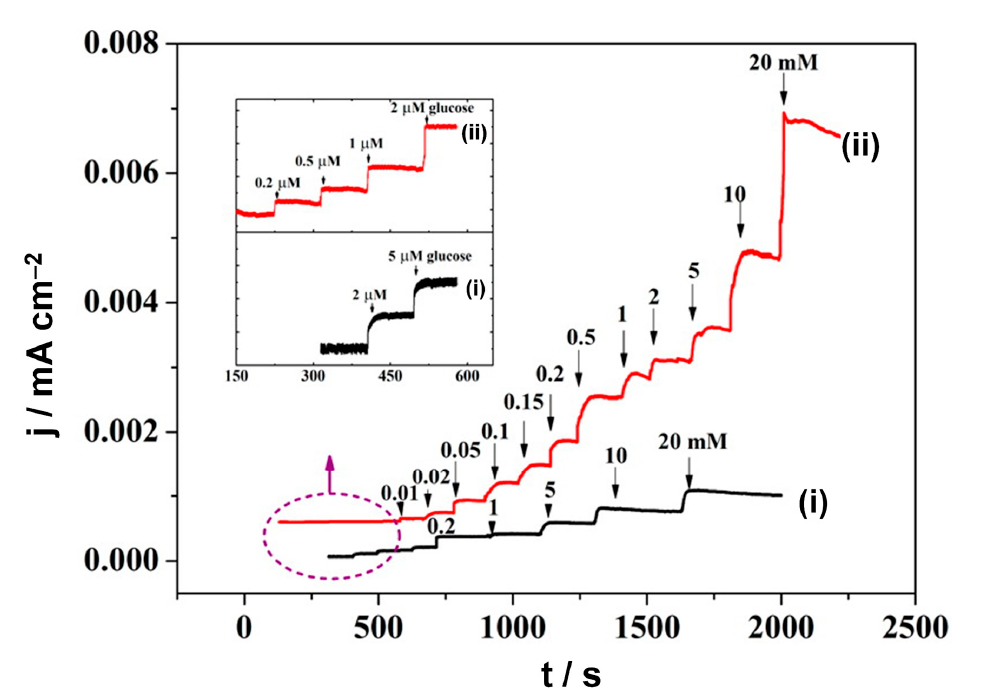
Figure 7. Amperometric response from the successive droppings of the glucose solution of different concentrations into 0.1 M NaOH solution of the cobalt oxide–modified FTO electrode: without Au (at 0.60 V vs. Ag|AgCl|KCl sat on CoO X /FTO: plot (i)) and with Au (at 0.30 V vs. Ag|AgCl|KCl sat on Au/CoO X /FTO: plot (ii)). Reprinted and adapted with permission from Reference [93]. Copyright American Chemical Society, 2016.